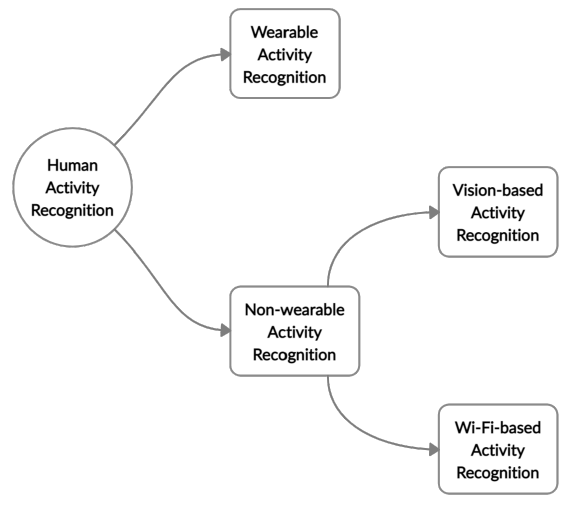
Figure 1. Overview of human activity recognition